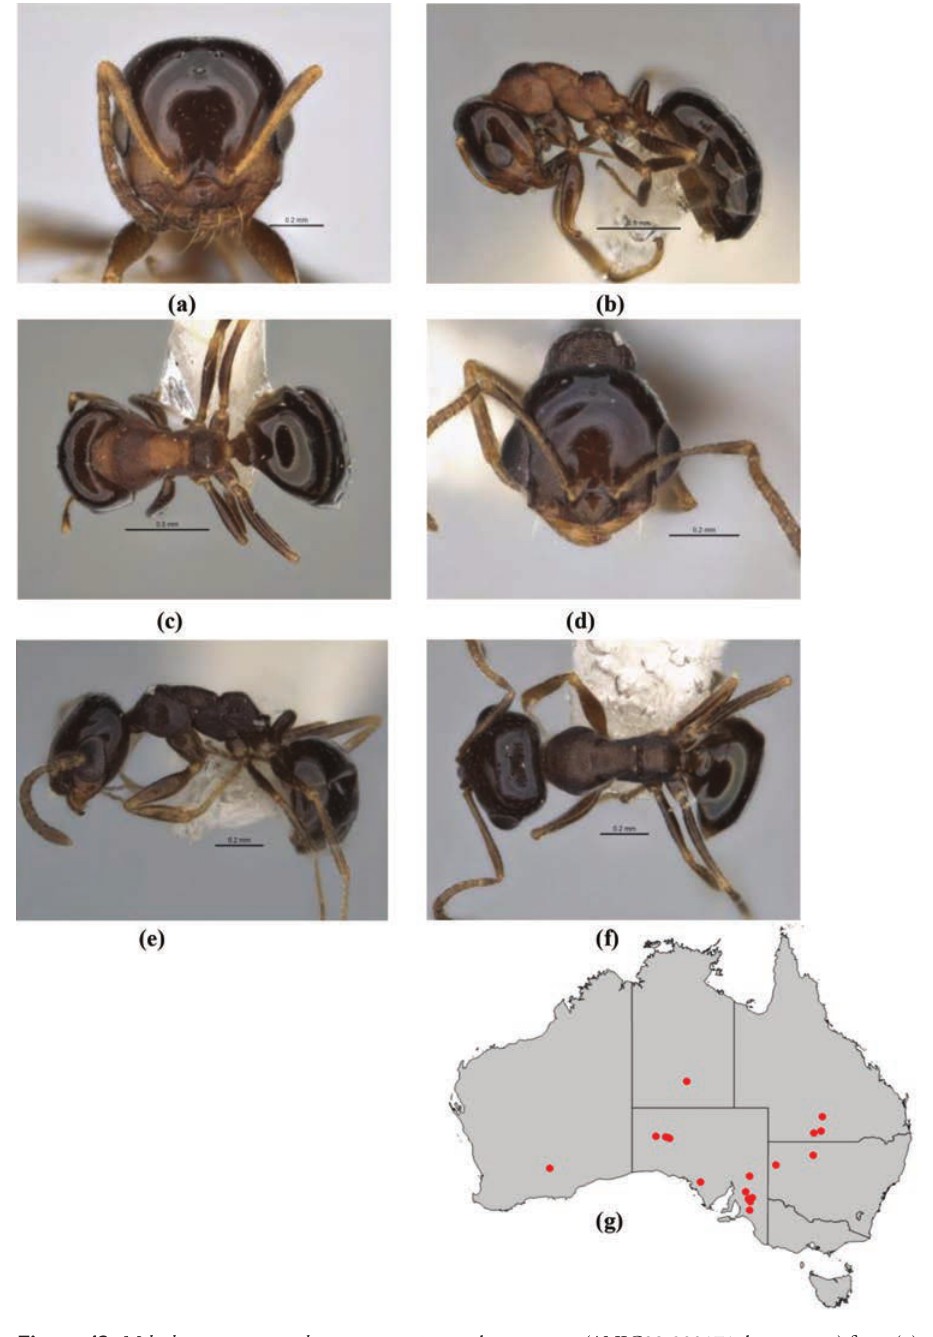
Figure 42. Melophorus microreticulatus sp. n.: major worker paratype (ANIC32-900171–bottom ant) frons ( a ), profile ( b ) and dorsum ( c ); minor worker holotype (ANIC32-900172) frons ( d ), profile ( e ) and dorsum ( f ); distribution map for the species ( g ). Low resolution scale bars: 0.5 mm ( b, c ); 0.2 mm ( a, d–f